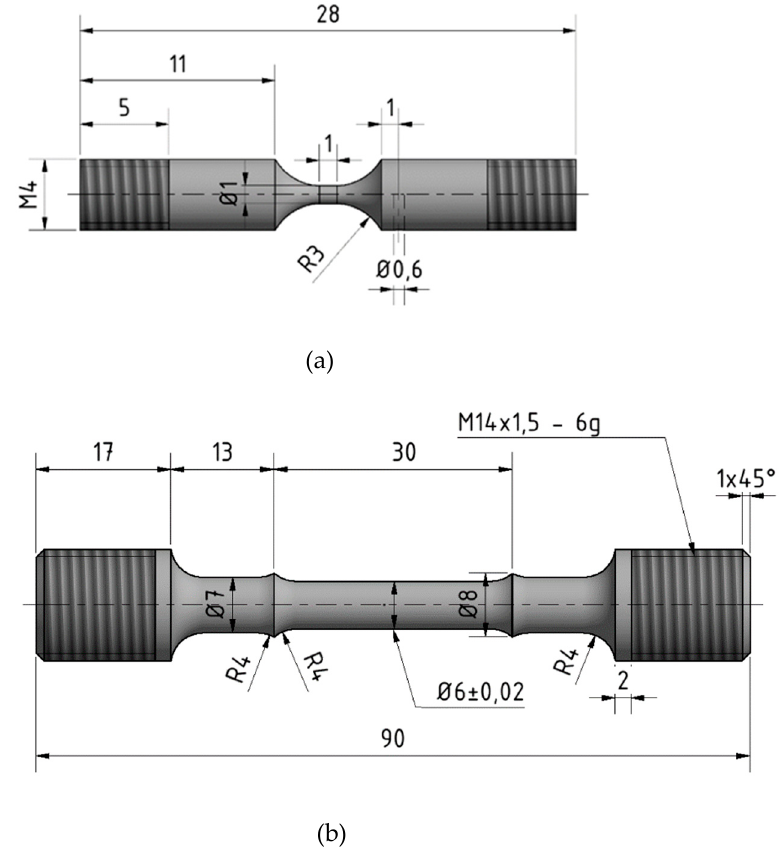
Figure 2. Geometries of the creep specimens, ( a ) miniature specimen, ( b ) standard specimen.